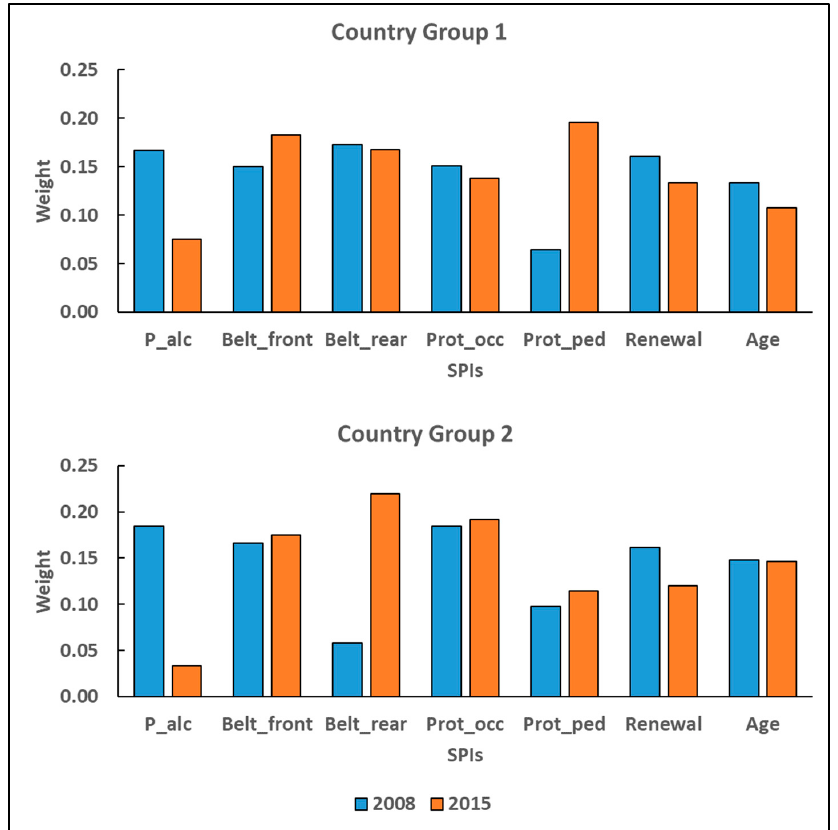
Figure 6. The assigned weights of SPIs for two country groups in 2008 and